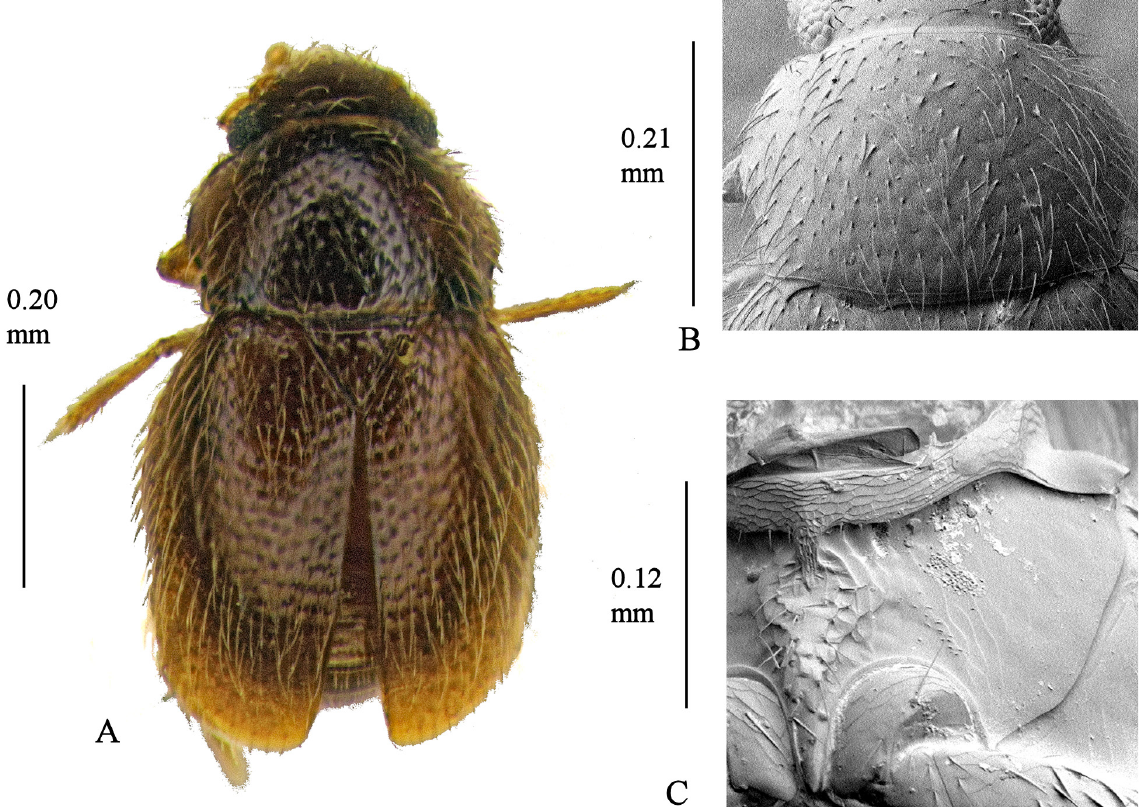
Fig. 52 . Cissidium latum Sawada, 2008. A . Habitus. B Pronotum, × 620. C . Mesoventrite showing median process of collar, mid-keel, keel and lateral margin,